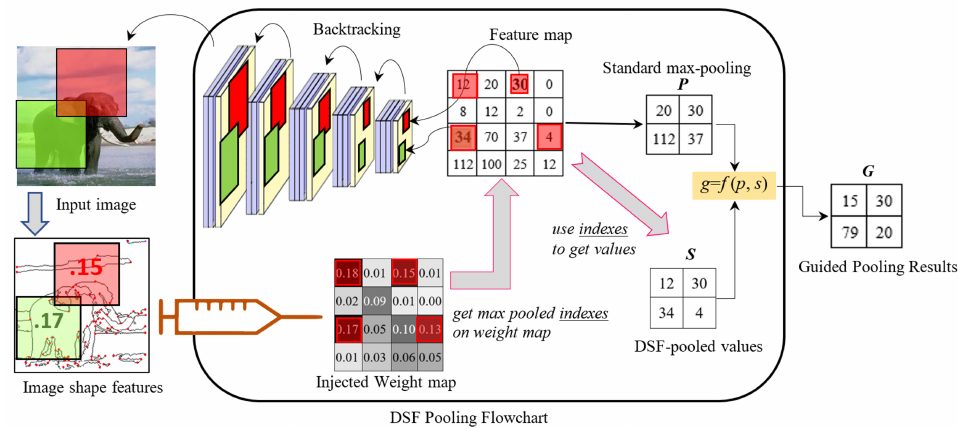
Figure 4. Flowchart of DSF-Pooling. Max pooled values P and the saliency S derived from the injected map are fused by Equation (2) to obtain the new pooled result